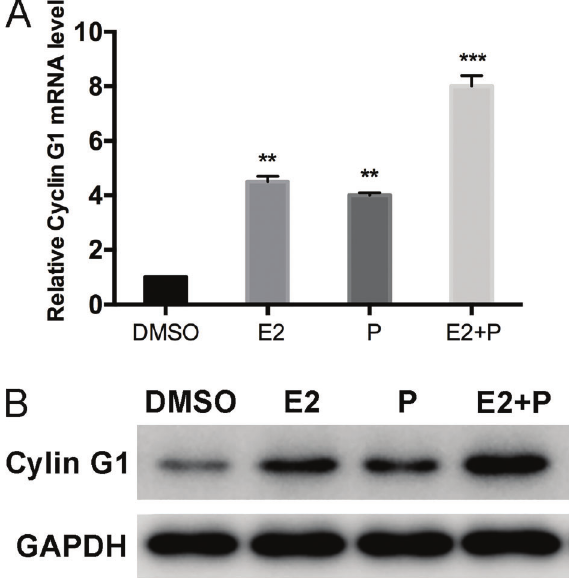
Figure 4. Effect of estradiol (E2) and progesterone (P) treatments on the mRNA expression of cyclin G1 ( A ), and on the protein level